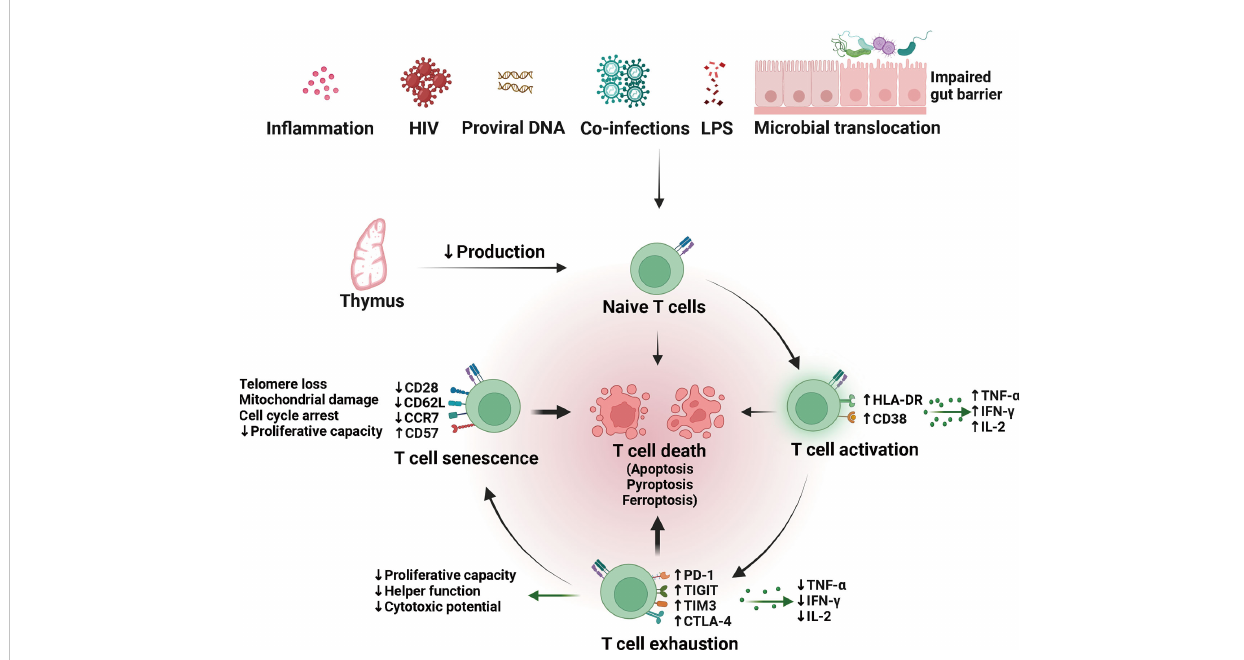
FIGURE 2 Quantity and quality alterations of T cells in HIV/AIDS patients with incomplete immune reconstitution. The naïve T (T N ) cells produced by the thymus can be activated by multiple factors, including persistent viral reservoir, low residual viremia, co-infections, microbial translocation and dysbiosis. Dif fi cult-to-remove risk factors may lead to persistent chronic immune activation, contributing to the development of T cell exhaustion and immune senescence. Exhausted and senescent T cells are qualitatively altered and prone to death, possibly through apoptosis, pyroptosis, and ferroptosis. LPS, lipopolysaccharide; HLA-DR, human leukocyte antigen DR; TNF- a , tumor necrosis factor-alpha; IFN- g , interferon-gamma; IL-2, interleukin-2; PD-1, programmed death-1; TIGIT, T cell immunoglobulin and ITIM domain; TIM3, T cell immunoglobulin domain and mucin domain- containing protein 3; CTLA-4, cytotoxic T lymphocyte